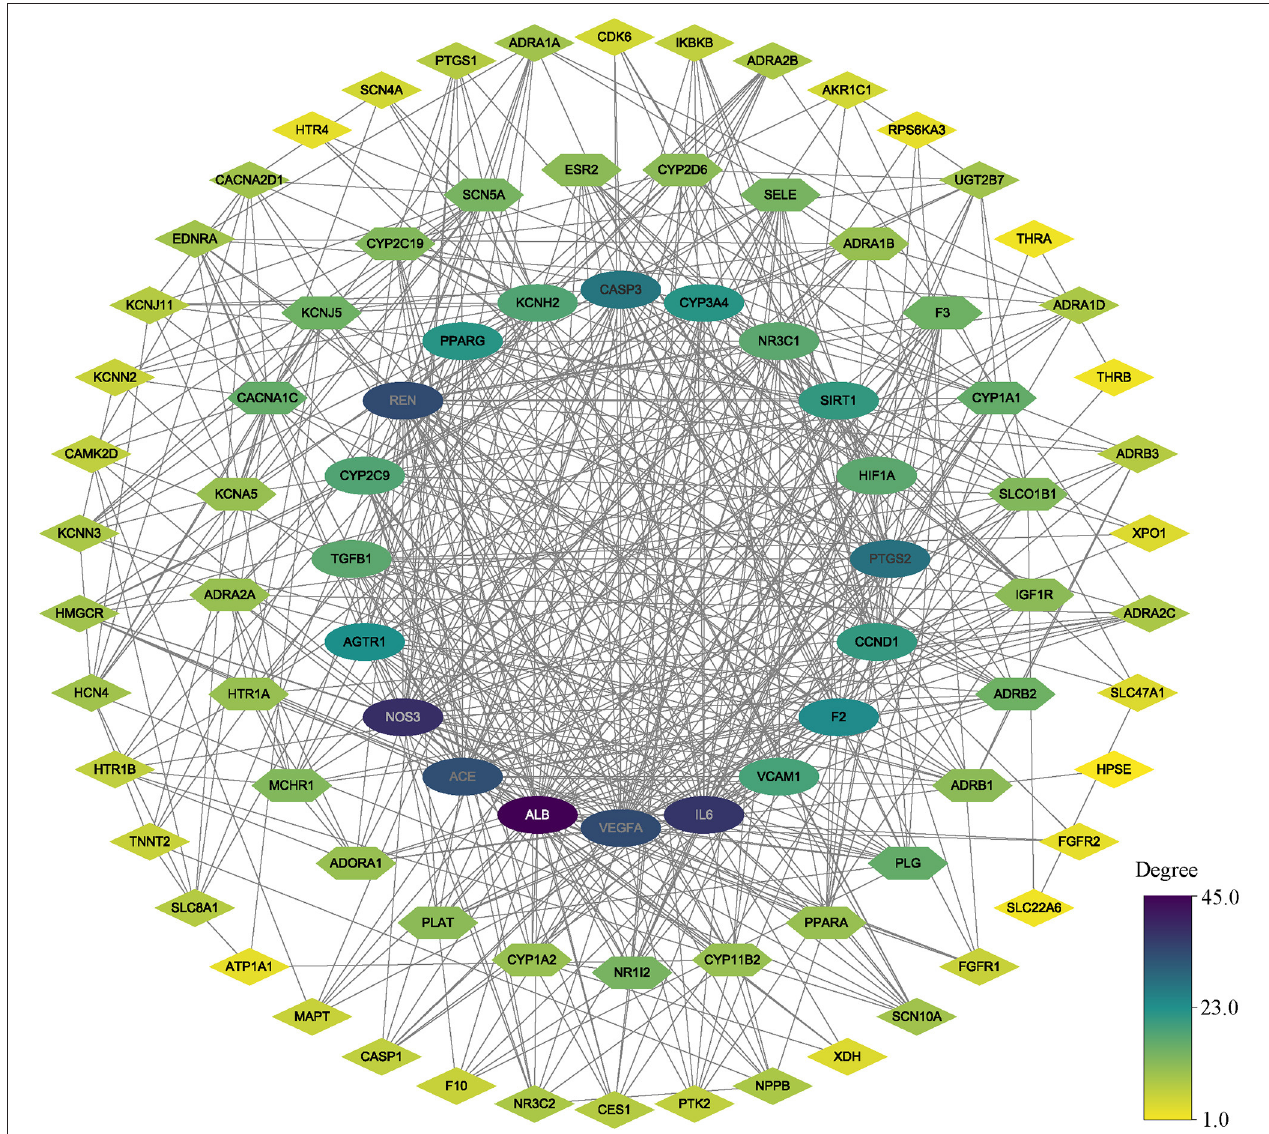
FIGURE 3 | The PPI network. All nodes colored according to the degree value. oval nodes on the inner circle indicate hub